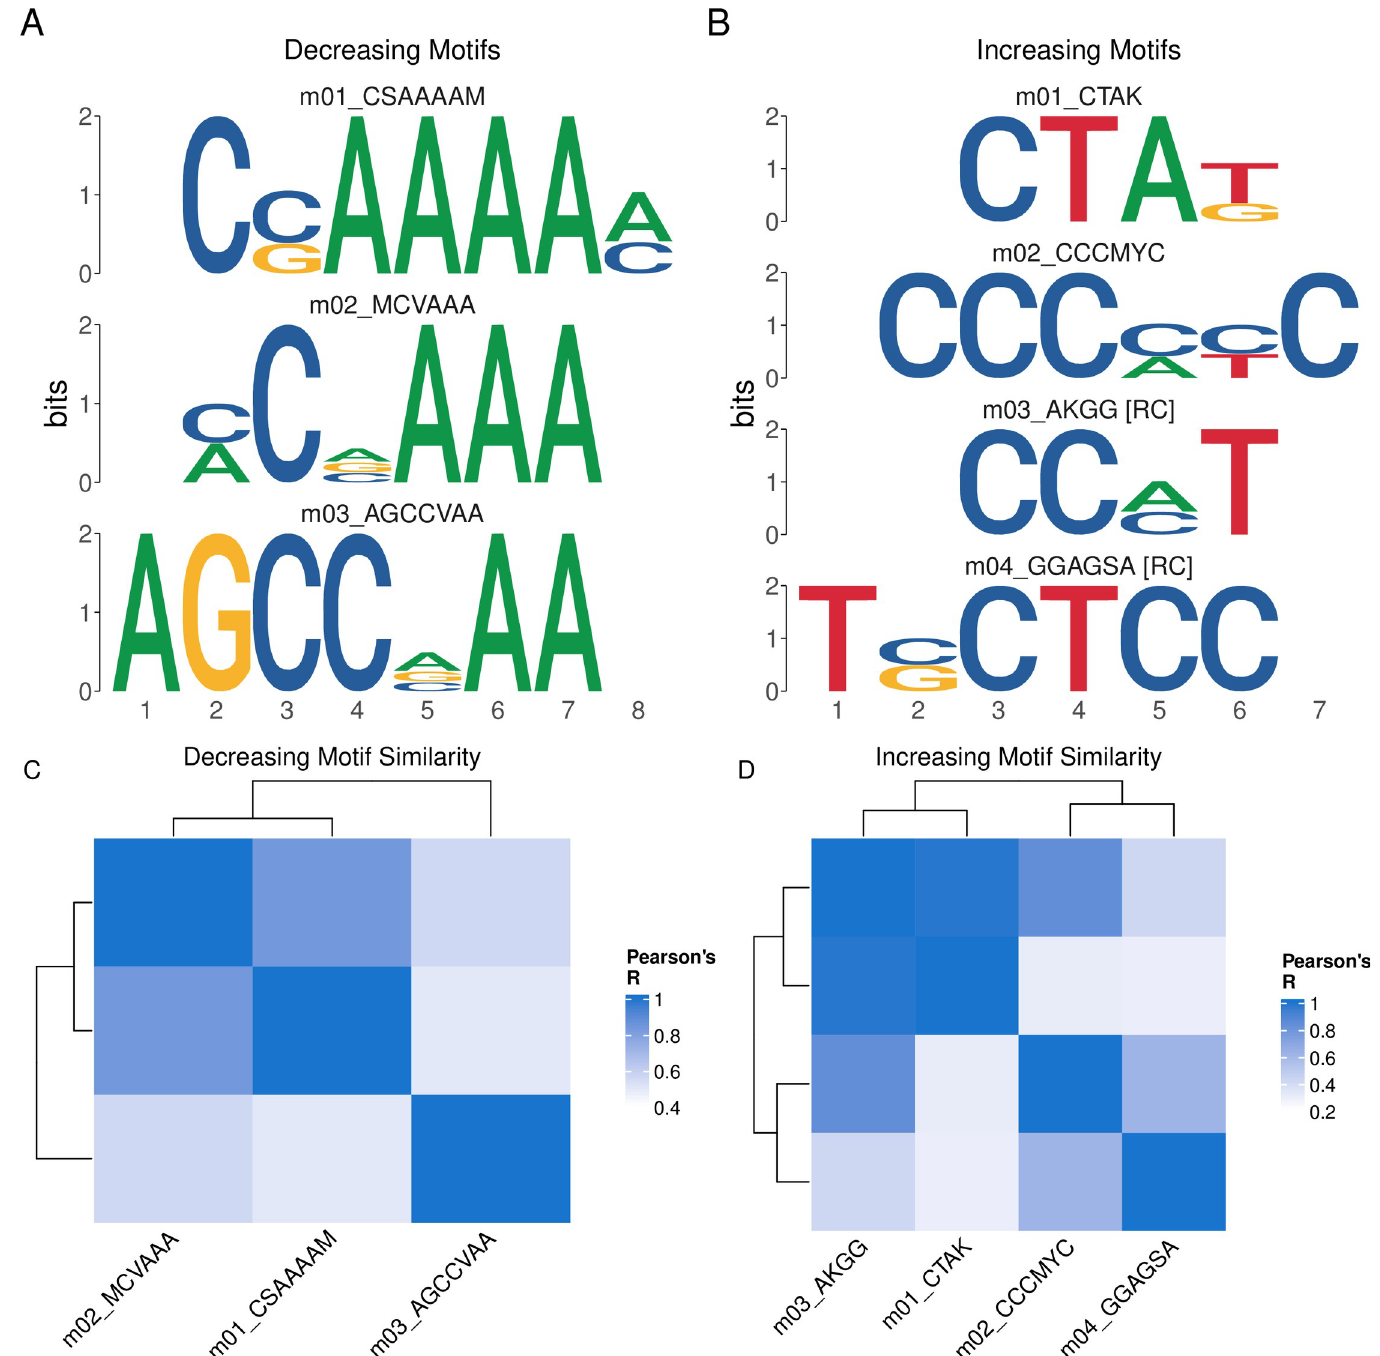
Fig 1. PWMs of discovered motifs in Decreasing (A) and Increasing (B) sites. C,D Pearson correlation heatmaps comparing similarity of Decreasing (C) and Increasing (D)